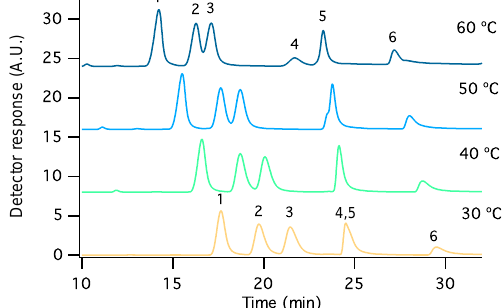
Figure 2. Separation of 1µgmL − 1 mixed amines standard with the final method gradient elution program at 30, 40, 50, and 60 ◦ C. The peak elution order was MMAH + (1), MEAH + (2), DMAH + (3), TMAH + (4), DEAH + (5), and TEAH + (6). The separation of di- ethylamine (DEA) from trimethylamine (TEA) was achieved at col- umn temperatures greater than 50 ◦